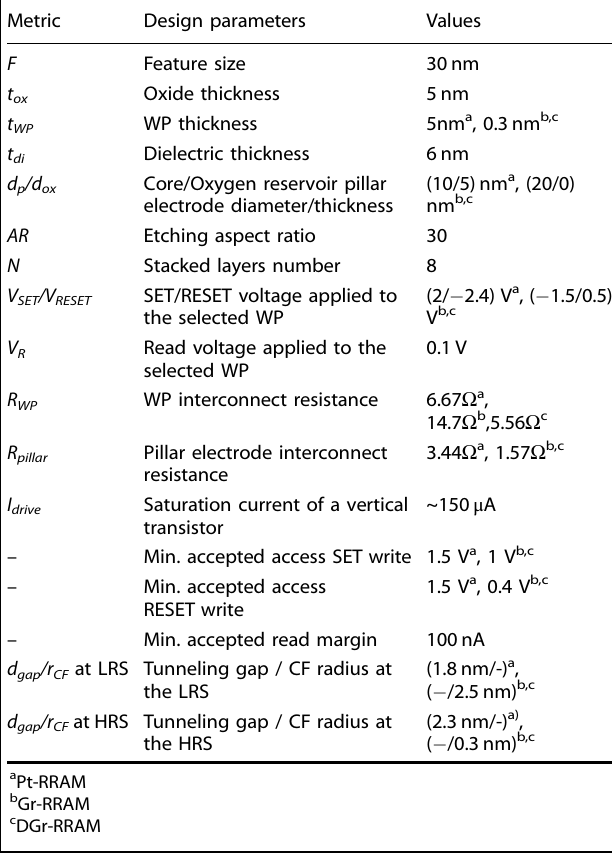
Table 1. VRRAM array simulation